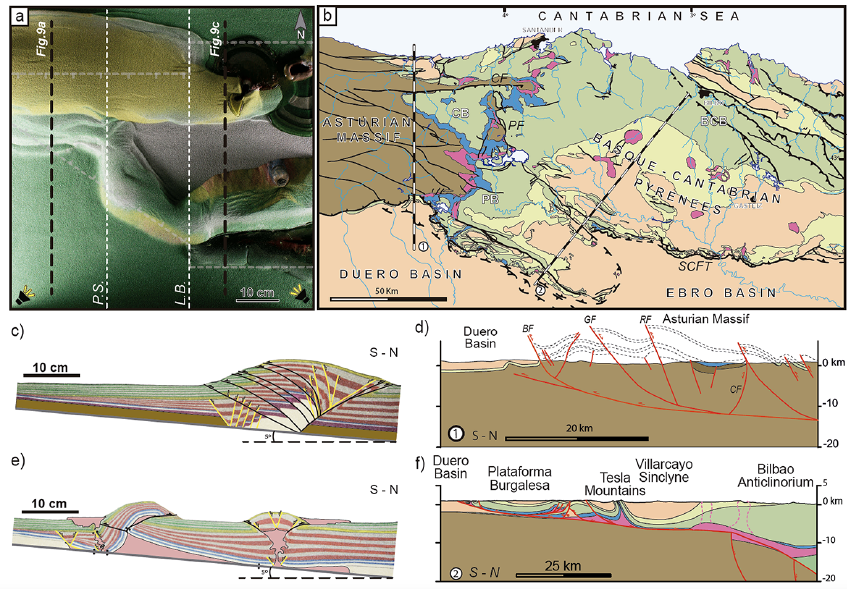
Figure 12. (a) Overhead view of model 3 at the end of the experiment. (b) Tectonostratigraphic map of the Basque–Cantabrian Pyrenees– Asturian Massif junction (modified from Miró et al., 2021). (c) Cross-section of the coupled domain showing the thick-skinned deformation in model 3. (d) Cross-section through the Asturian Massif (modified from Espina, 1996) showing the thick-skinned deformation similar to what was observed in the model. (e) Cross-section through the decoupled domain in model 3. (f) Cross-section across the southern Basque– Cantabrian Pyrenees showing the characteristic thin-skinned deformation of the area. BF: Becerril Fault, GF: Golobar Fault, RF: Rumaceo Fault, CF: Cabuérniga